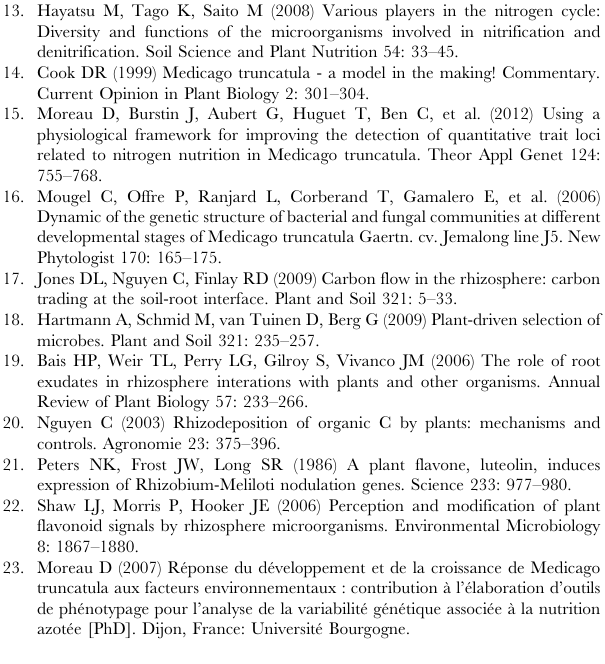
Table S2 Developmental characterization and C and N nutritional strategies of different Medicago truncatula genotypes under two contrasted N treatments (0 and 10 mM N). SNU represents the specific nitrogen uptake. SNU is the correlation coefficient of the function between the total amount of nitrogen (g plant 2 1 ) and below-ground biomass (g plant 2 1 ). NLA represents the conversion factor of nitrogen to leaf area. NLA is the correlation coefficient of the function between leaf area (cm 2 plant 2 1 ) and the total amount of nitrogen (g plant 2 1 ). RUE represents the radiation use efficiency. RUE is the correlation coefficient of the function between total biomass (g plant 2 1 ) and the sum of intercepted PAR (MJ plant 2 1 ). Root:total biomass ratio is the correlation coefficient of the function between below-ground biomass (g plant 2 1 ) and total biomass (g plant 2 1 ). SNU, NLA, RUE and root:total ratio were calculated from three dates (340, 634 and 934 degree-days) and 4 plant